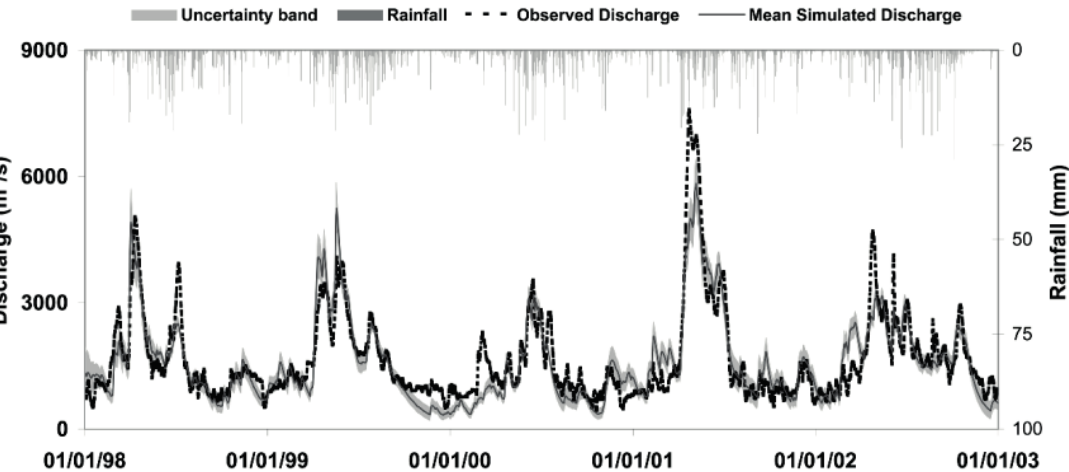
Fig. 4 The simulated streamflow with the 90% uncertainty limits by the behavioural parameter sets derived from the calibration against streamflow